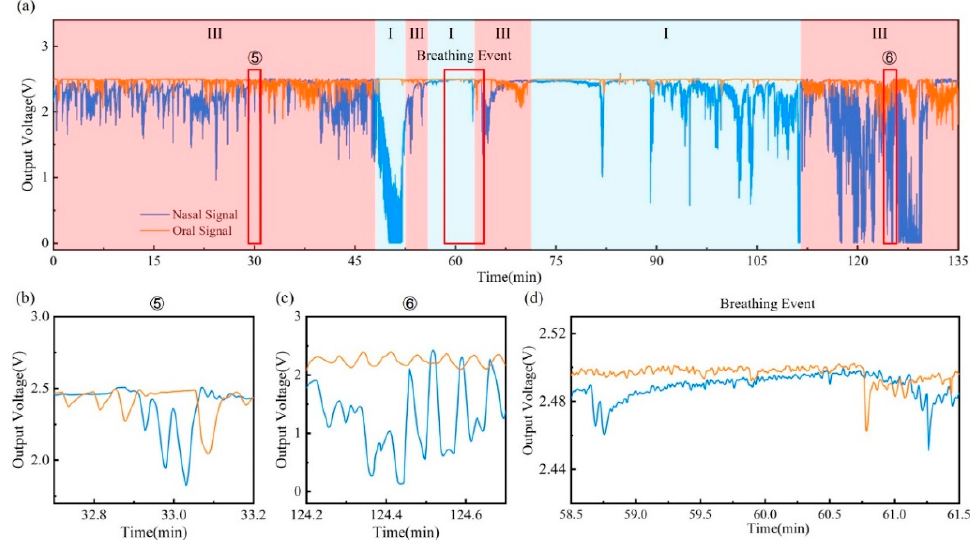
Figure 6. Sleep respiratory monitoring of apnea patient: ( a ) Breathing signals throughout the test (I: nasal breathing; III: oral–nasal co-breathing). Detailed signals for different sleeping stages during the test, including ( b , c ) oral–nasal co-breathing (stage ⑤ and stage ⑥ ) and ( d ) breathing event.